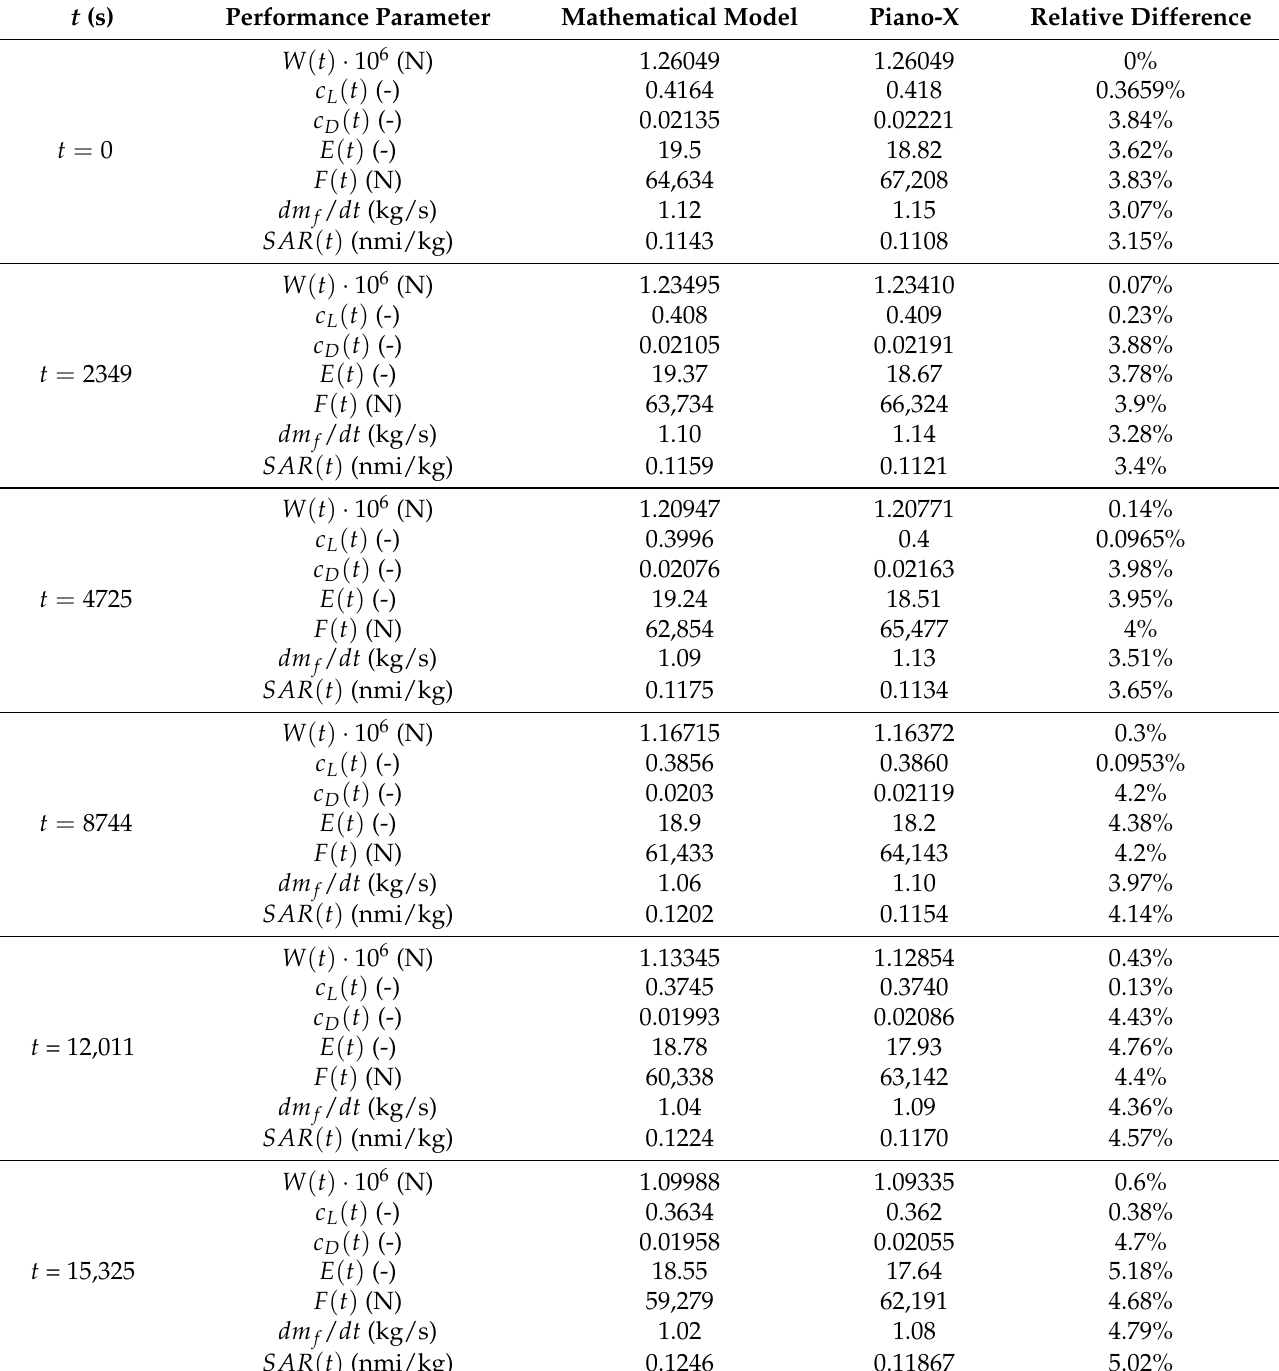
Table 2. Performance parameters computed by using Piano-X and our mathematical